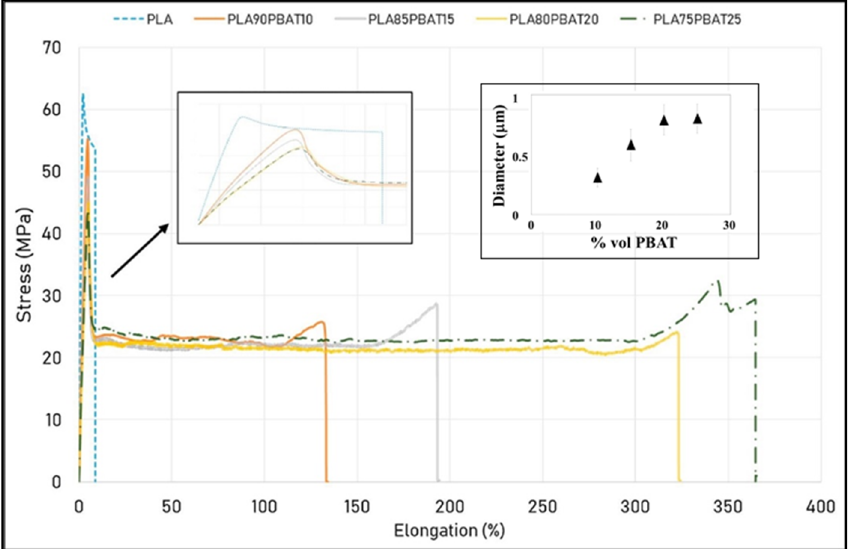
Figure 1. Stress-strain curves of PLA/PBAT blends and in the inset particle dimension analysis. Reprinted (adapted) with permission from Ref. [74]. Copyright 2019 Elsevier.